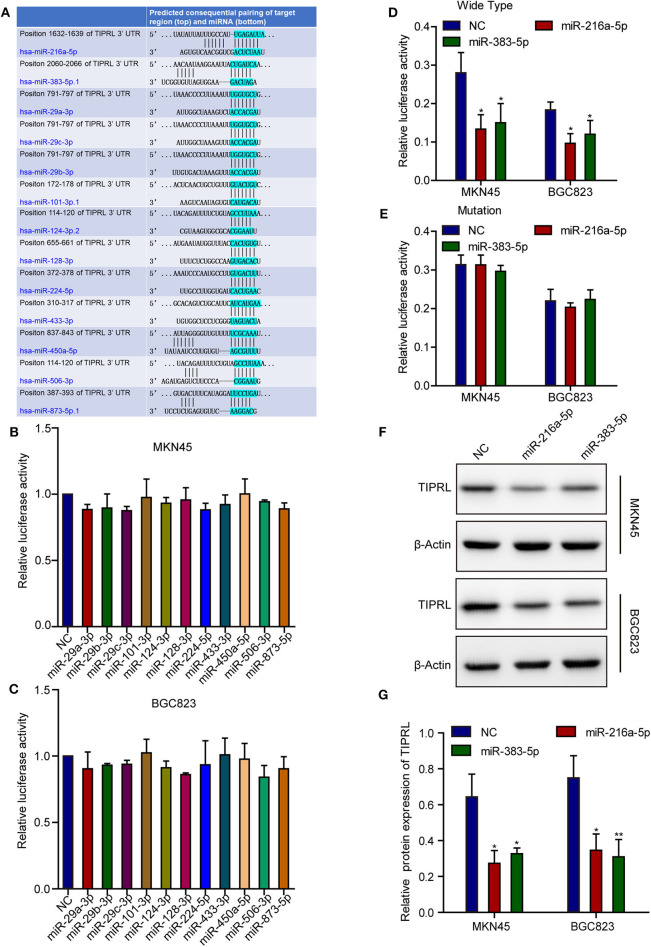
MiR-216a-5p and miR-383-5p repress TIPRL expression through directly targeting its 3′-UTR. (A) Schematic illustration of the putative miRNAs binding sites in 3′-UTR of TIPRL. (B–E) The wild-type and mutant form of TIPRL 3′-UTR regions were fused with a luciferase reporter (pmirGLO) and luciferase reporter assay was performed. MiR-216a-5p/383-5p rather than other miRNAs significantly inhibited the luciferase activity of wild-type TIPRL 3′-UTR reporters in MKN45 and BGC823 cells (B–D, t-test, *P < 0.05). Meanwhile, the luciferase responsiveness to miR-216a-5p/383-5p was abrogated by mutation of TIPRL 3′-UTR (E). (F,G) Western blot analysis showed that up-regulated expression of miR-216a-5p/383-5p resulted in decreased protein expression of TIPRL. (t-test, *P < 0.05; **P < 0.01).